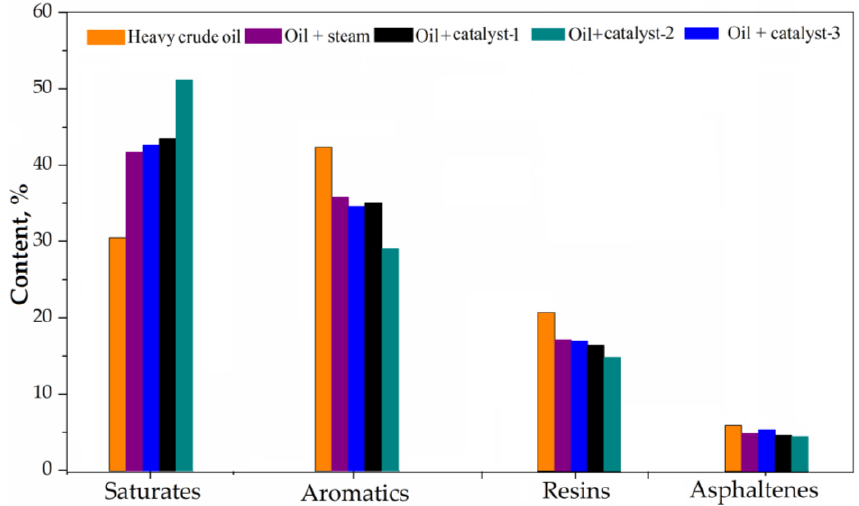
Figure 9. SARA fractions of heavy crude oil and upgraded oil samples.